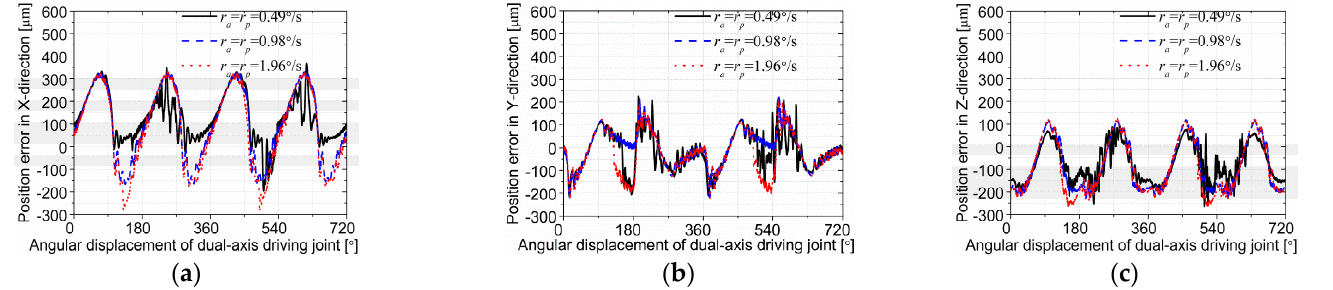
Figure 19. Position error of antenna reflector with different rotational speeds in dual-axis driving mode: ( a ) component